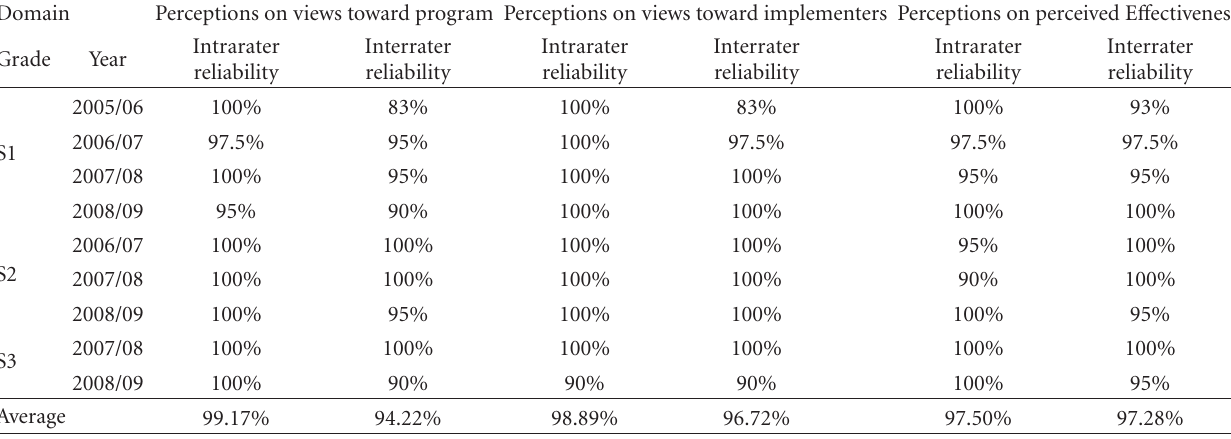
Table 7: Reliability results across